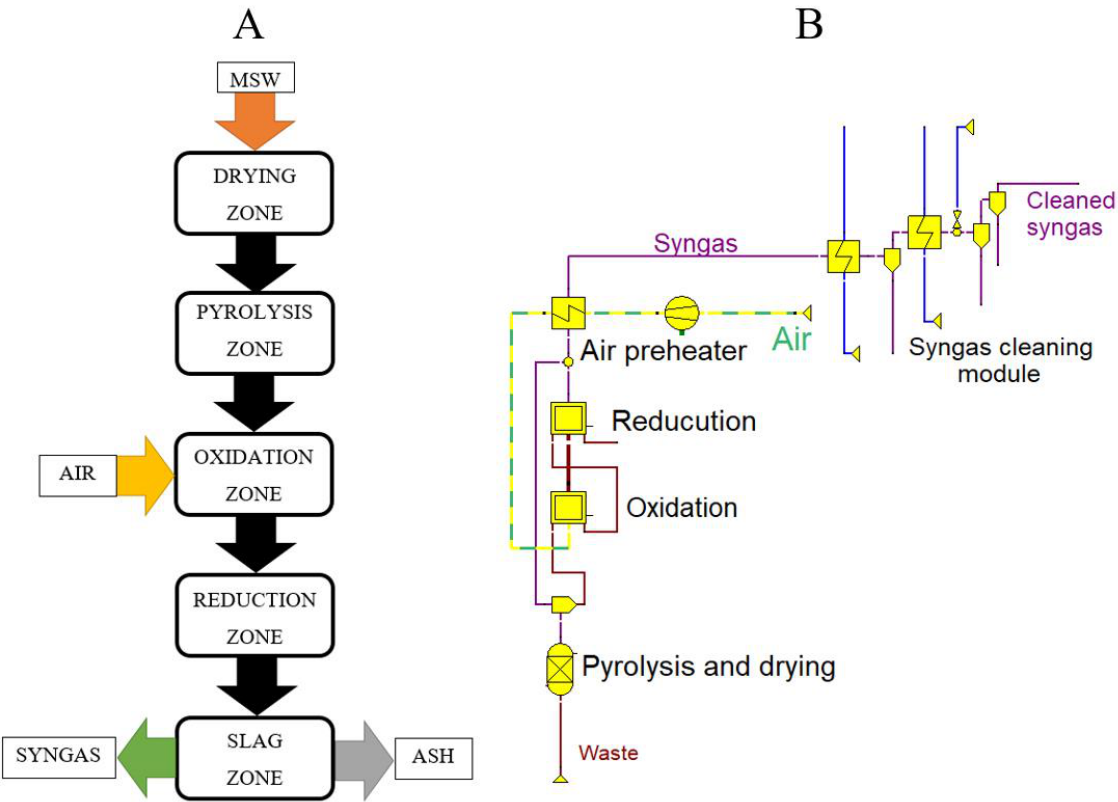
Figure 5. Gasifier: ( A ) block diagram, and ( B ) model.